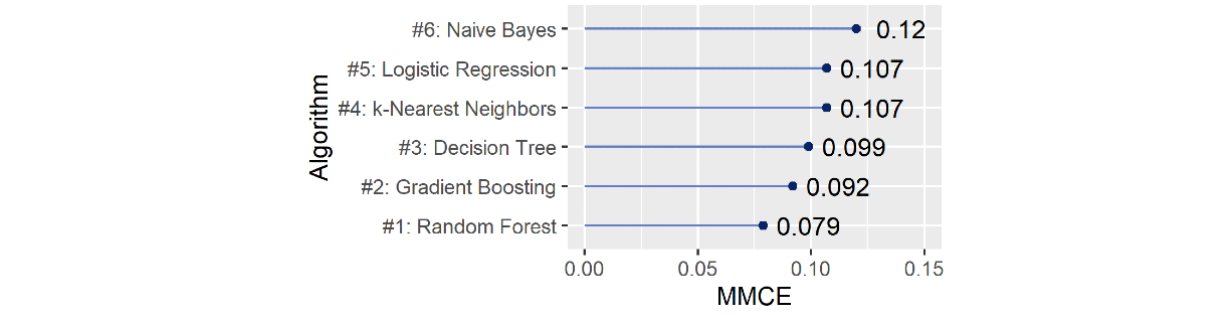
Figure 7. Comparison of algorithms according to the mean of misclassification error